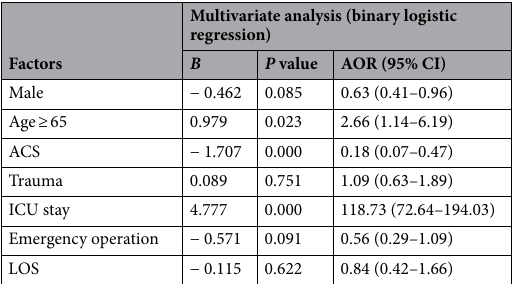
Table 2. Factors associated with in-hospital mortality (multivariate analysis).